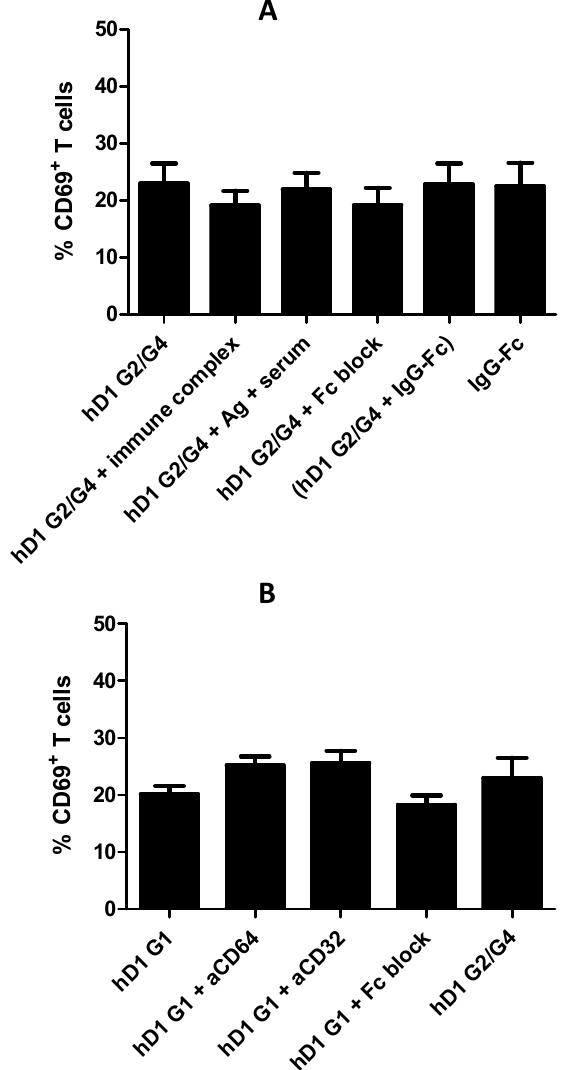
Figure 6. Combining DC-SIGN and FcR binding is not sufficient to boost antigen presentation. Human monocyte-derived DCs were cultured in the presence NP vaccines harbouring gp100 (272–300) peptide Ag and TLRLs. Subsequently, DCs were co-cultured with gp100 280-288-specific naïve CD8 + T cells. The percentage of activated T cells is determined by measuring CD69 expression. ( A ) NP vaccines were coated with DC-SIGN targeting Ab hD1 G2/G4. Immune complex was added to trigger FcRs (immune complex), whereas samples with irrelevant Ag and non-reactive serum served as negative control (Ag + serum). Other samples contained NP vaccines coated with hD1 G2/G4 in the presence of excess IgG (Fc block), NP vaccines coated with a combination of functional Fc domains and hD1 G2/G4 (hD1 G2/G4 + IgG-Fc) or NP vaccines coated only with functional Fc domains (IgG-Fc). ( B ) To block FcR binding of NP vaccines coated with hD1 G1, 20 µg/mL CD64 or CD32 blocking antibodies or excess IgG (Fc block) was added to the culture medium. ( C ) NP vaccines were coated with the DC-SIGN targeting Ab hD1 G1, which carries an unmodified, functional IgG1 Fc domain or with hD1 G2/G4. To analyse the role of FcR, it was blocked as in ( B ). Data are means ±SD of 3 experiments performed in duplicate using cells of unrelated donors.